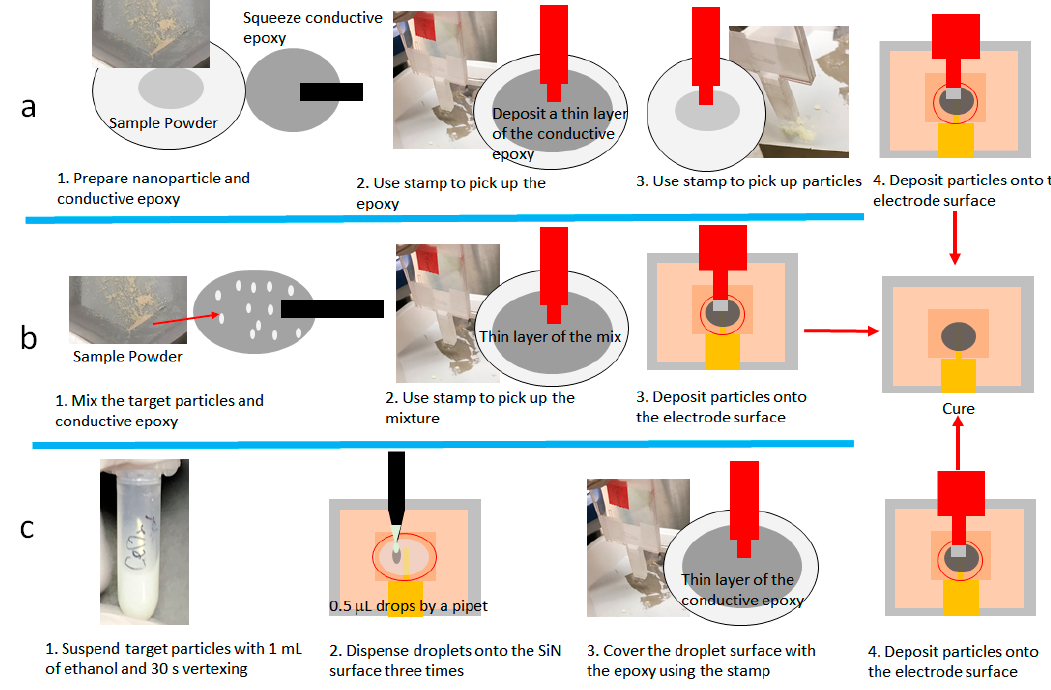
Figure 1. Overview of three different silver conductive epoxy stamping methods for depositing nanoparticles onto the electrode: ( a ) sequence stamping; ( b ) mix stamping; and ( c ) droplet stamping.